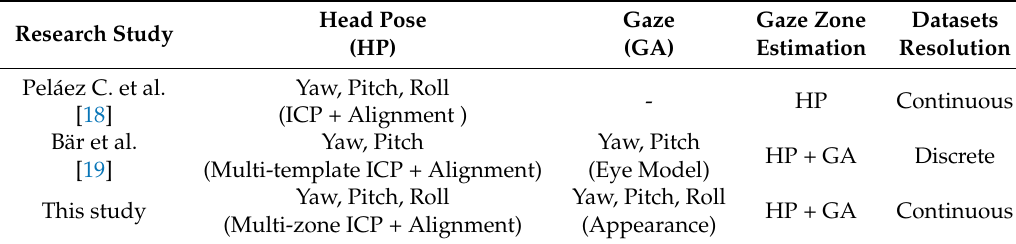
Table 1. Review of driver gaze zone Estimation Methods/Systems Using an RGB-D Camera.